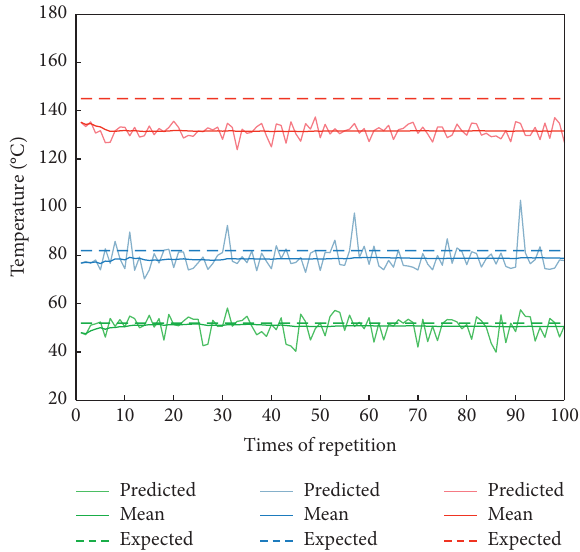
Figure 9: The temperature estimations of three samples with 100 times repetition.